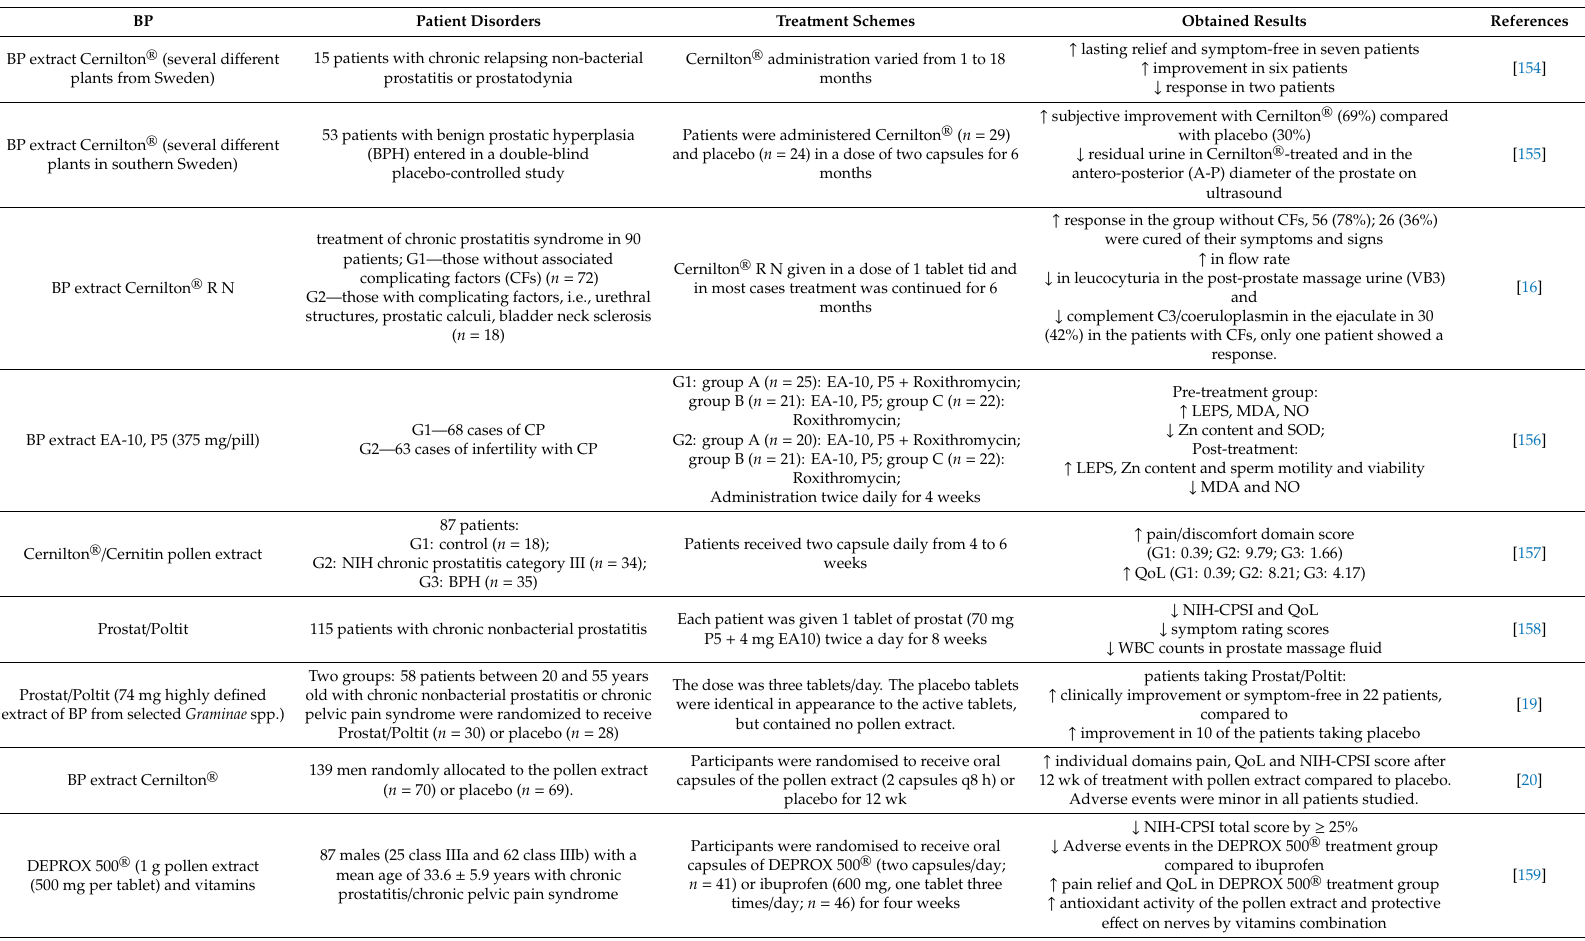
Table 6. E ff ects of BP extract treatmens in patients with chronic prostatitis or chronic pelvic pain